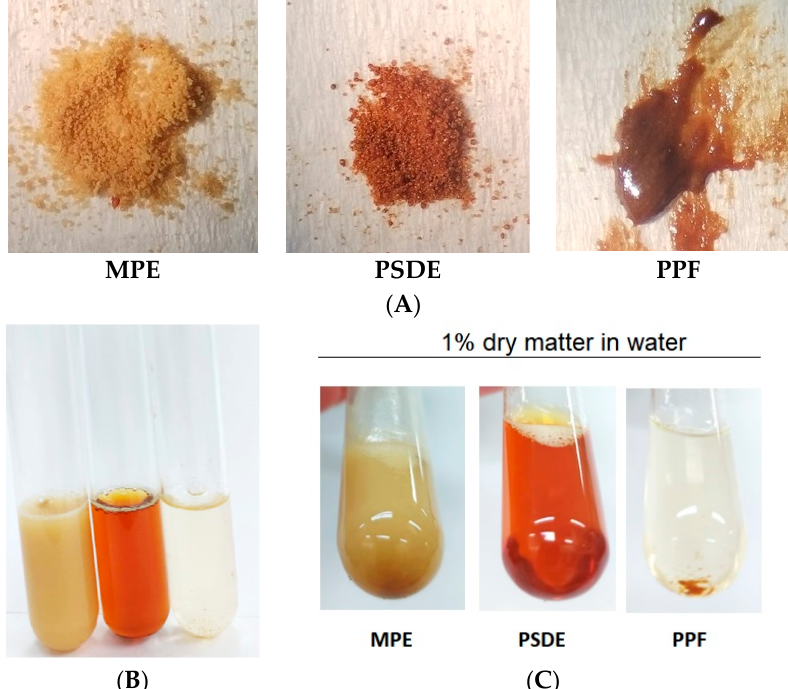
Figure 1. Visual aspects of ( A ) the three extracts from left to right: microencapsulated propolis extract (MPE), propolis soluble dry extract (PSDE), and polar propolis fraction (PPF); ( B ) immediately after mixing in water to obtain 1% w / v propolis dry matter, in the same order as in a; ( C ) after 30 min, showing precipitates of PPF.